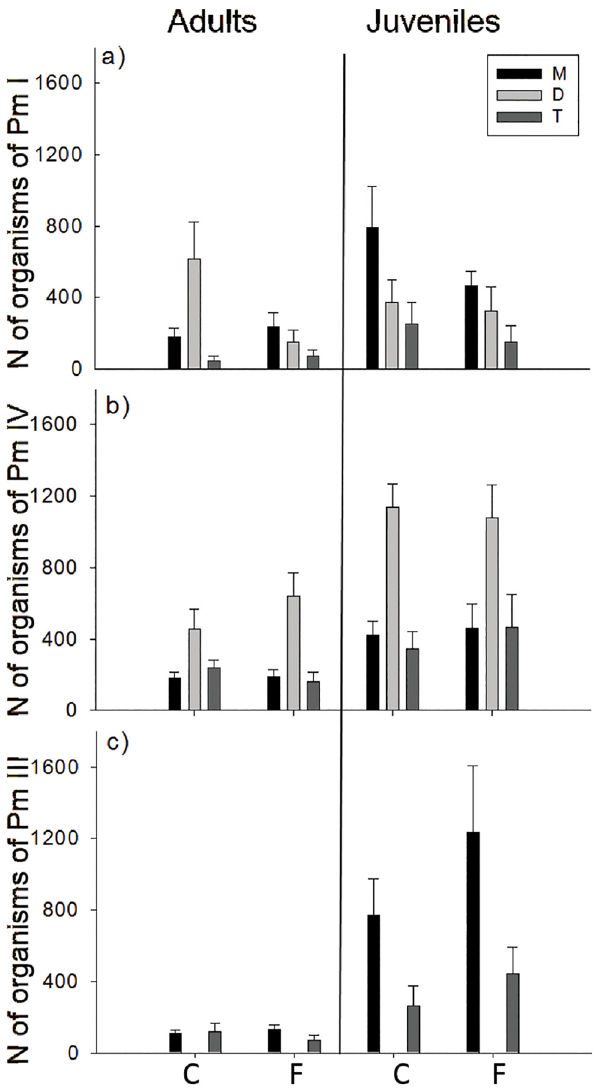
Fig 1. Time-averaged number of nematodes ( ± SE) of Litoditis marina species (adults and juveniles) in the different interspecific interaction treatments (three species: T, two species: D and one species: M) and different temperature treatments (F and C) for (a) Pm I, (b) Pm IV and (c) Pm